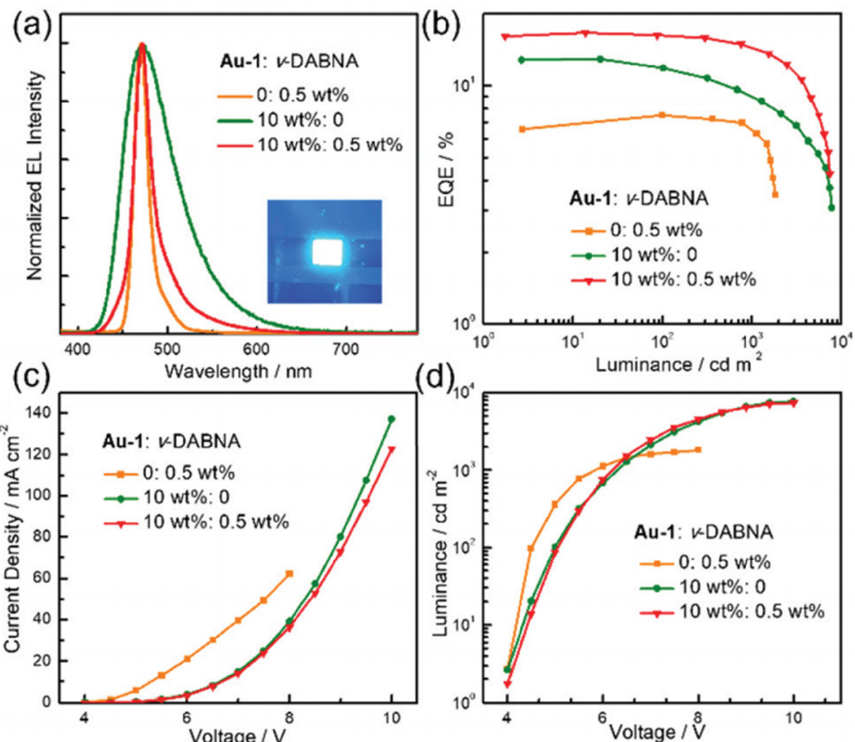
Figure 10. ( a ) Normalized EL spectra, ( b ) EQE–luminance, ( c ) current density–voltage, and ( d ) luminance–voltage characteristics of OLEDs with different concentrations of Au(III)-1 and v-DABNA. The image of the sensitized OLED is shown in the inset of ( a ). Reproduced from Ref. [40] with permission from the Royal Society of Chemistry.